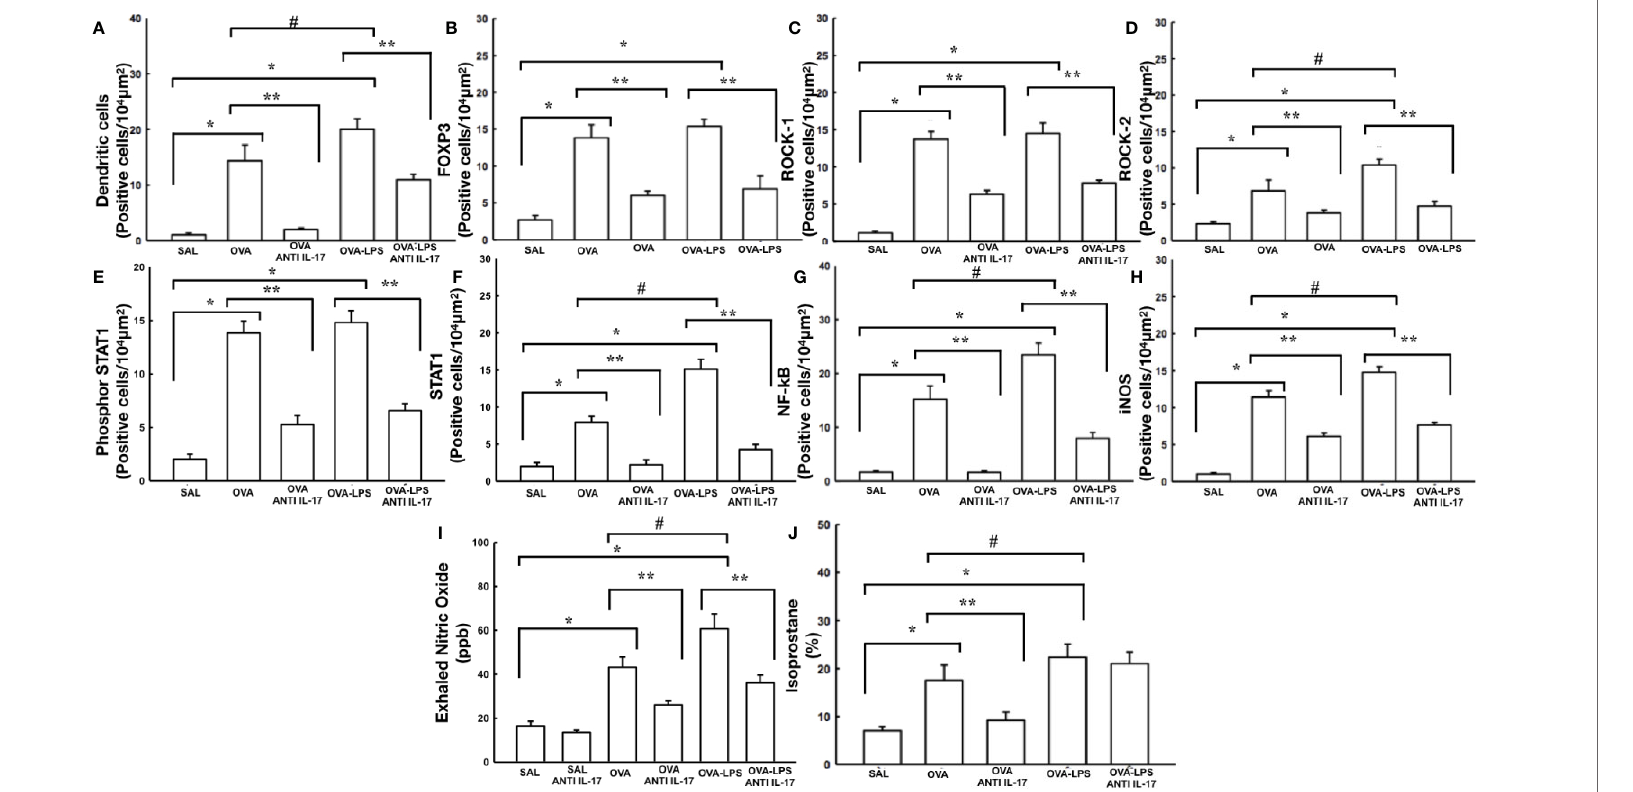
FIGURE 9 | Effects of anti-IL 17 treatment on antigen-presenting cells (A) , FOxP3 (B) , signaling pathways (C – G) , and oxidative stress (H – J) . The values represent the mean ± SE of dendritic cells, FoxP3, ROCK-1, ROCK-2, Phosphor-STAT1, STAT1, NF-k, iNOS, NOex, and isoprostane for all experimental groups. The differences were considered signi fi cant when p<0.05. *p<0.05 vs. SAL group; **p<0.05 vs. OVA and OVA – LPS groups. # p<0.05 vs. OVA